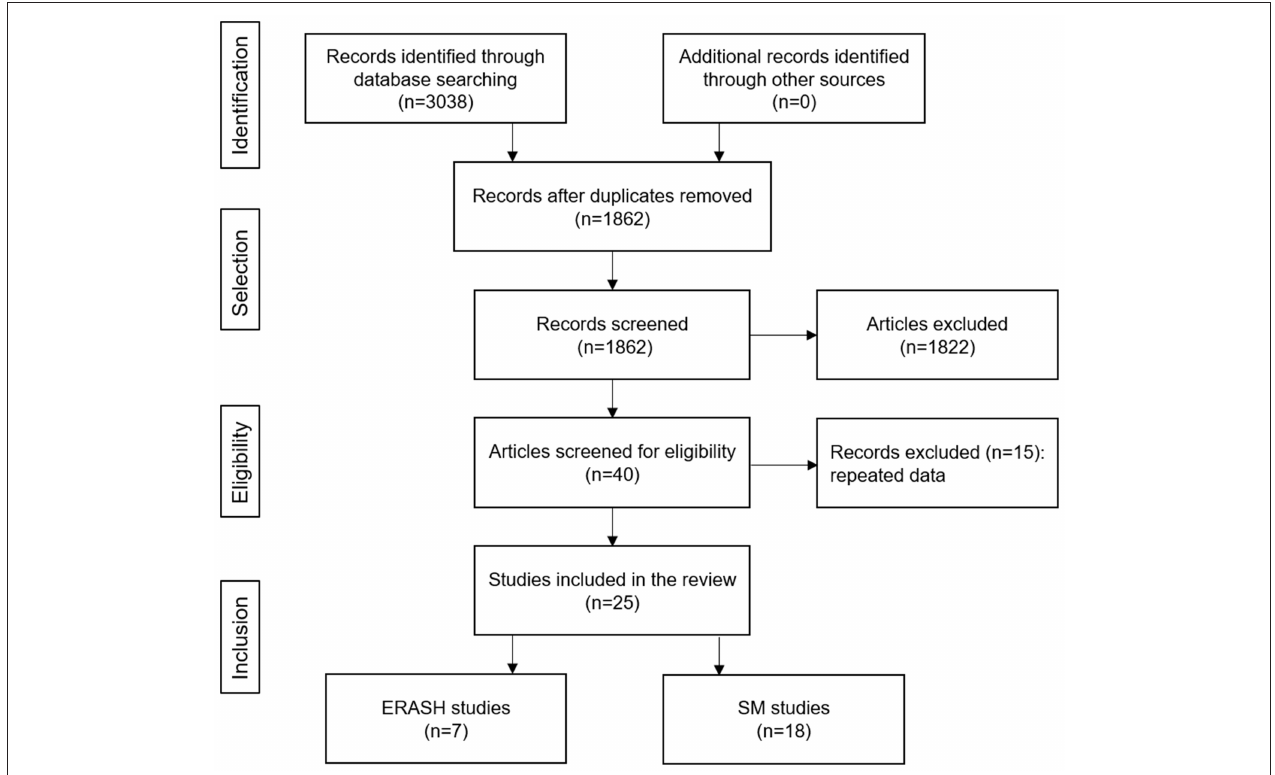
FIGURE 1 | Flowchart of the study selection process. ERASH, endocardial radiofrequency ablation of septal hypertrophy; SM, septal